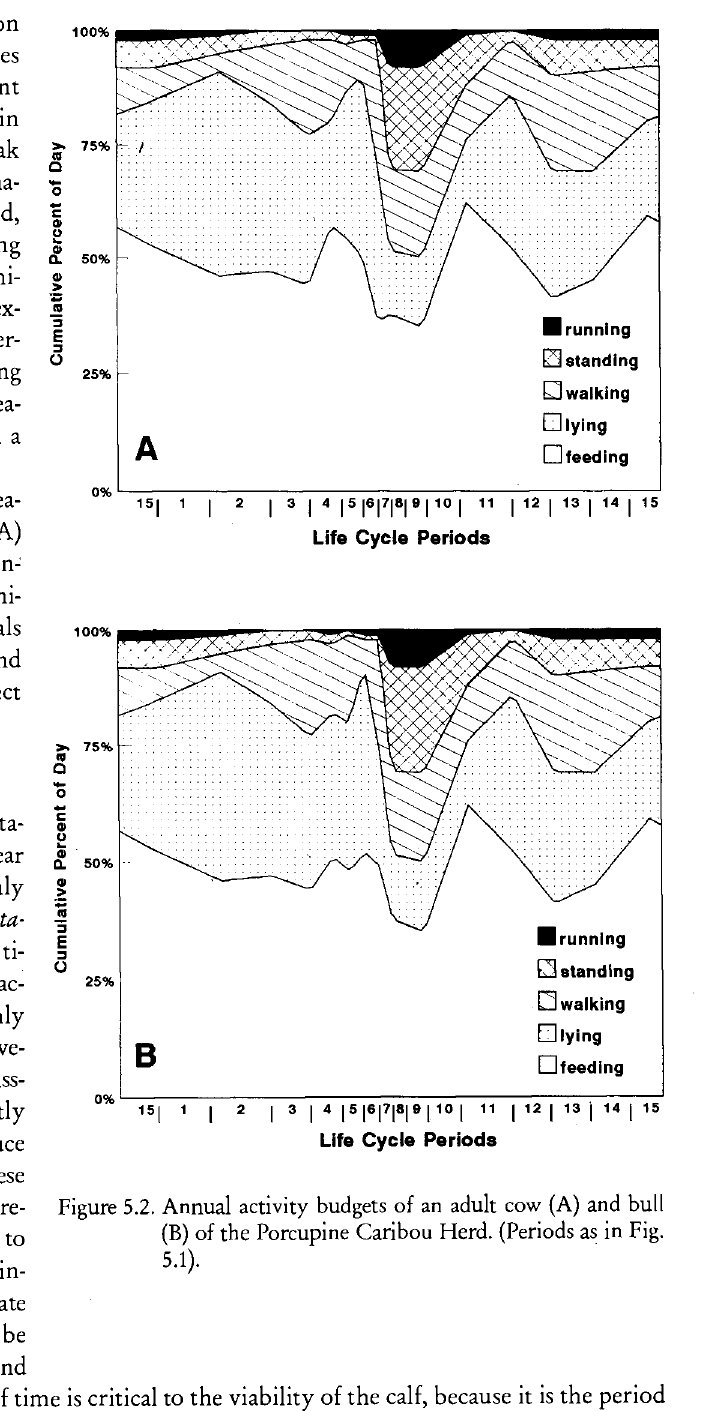
Figure 5.2. Annual activity budgets of an adult cow (A) and bull (B) of the Porcupine Caribou Herd. (Periods as in Fig.